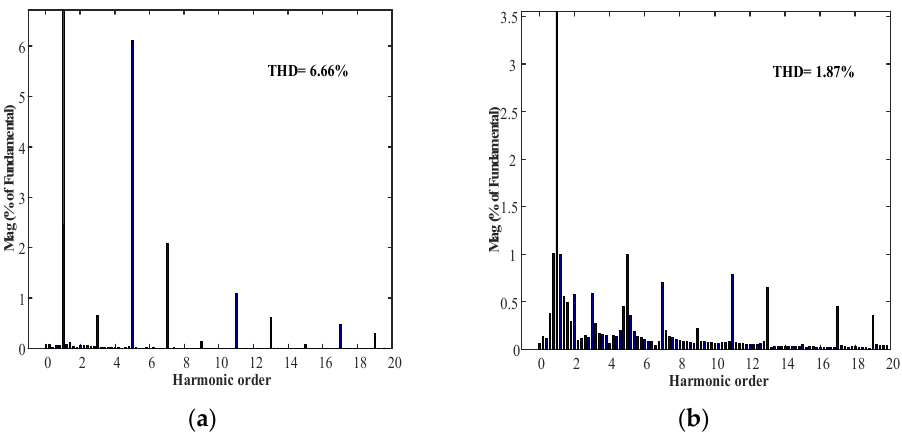
Figure 11. Comparison of before and after voltage harmonic content compensation: ( a ) harmonic content before compensation; ( b ) harmonic content after compensation.